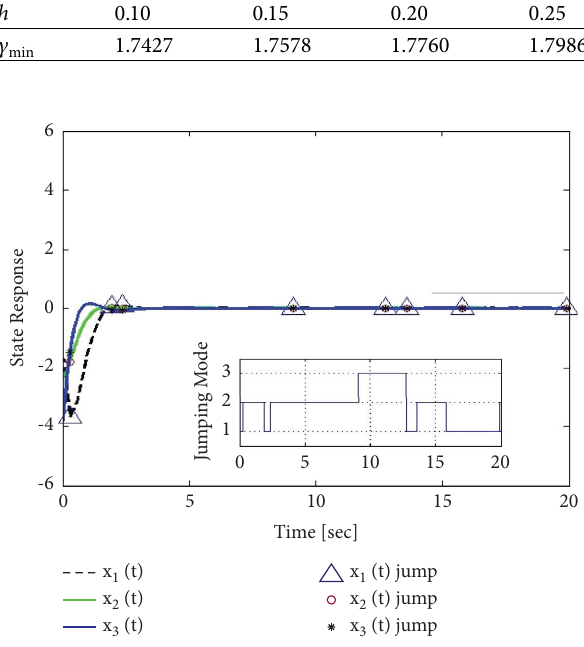
Figure 1: System state response and Markovian-jump signals in example.